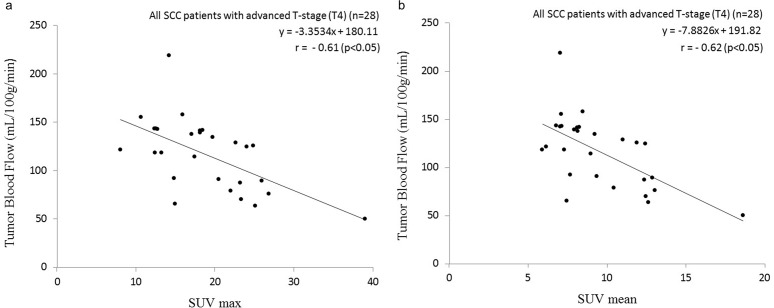
Scatterplot of the SUV and TBF values in all patients with an advanced T-stage (T4) SCC.There were significant negative correlations between the SUVmax and TBF and between the SUVmean and TBF values. Pearson’s correlation coefficient between SUVmax and TBF was −0.61 (p<0.05) (a), and that between SUVmean and TBF was −0.62 (p<0.05) (b).